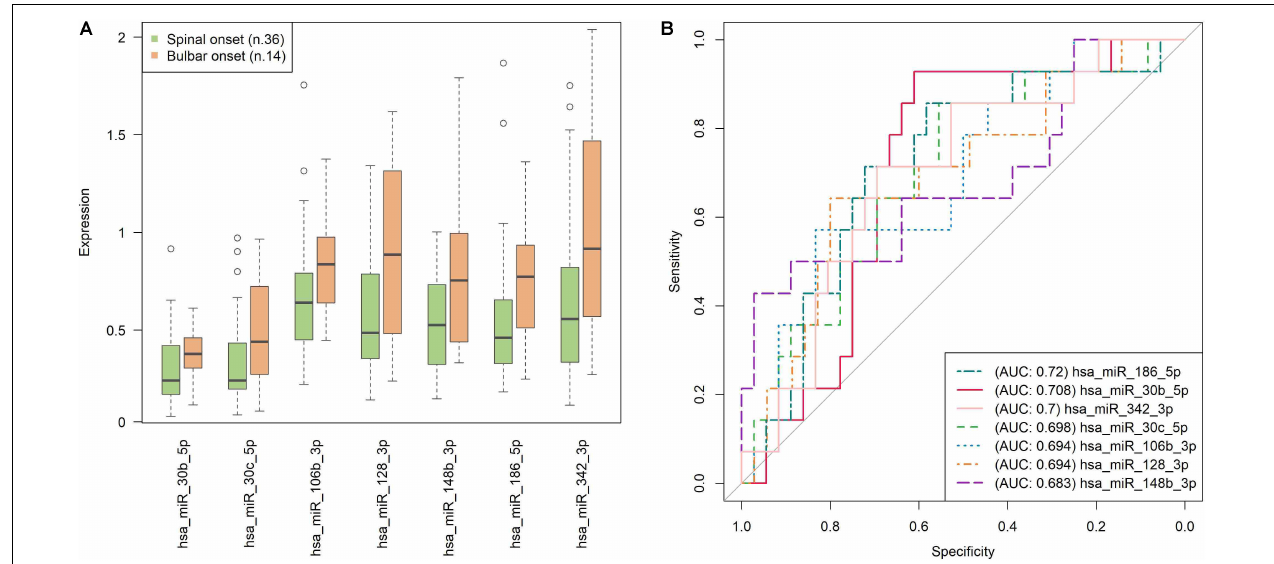
FIGURE 2 | Prediction accuracy of significant miRNAs with respect to the type of disease onset (spinal/bulbar). (A) Each boxplot shows the 25 th and the 75 th percentiles on the bottom and top of the box, the band inside the box is the 50 th percentile (the median) and the ends of the whiskers are the minimum and maximum of the data. Outliers are showed as isolated circles. (B) ROC curves based on miRNAs relative expression data (as resulted from qRT-PCR analysis). In our sample, the AUCs close to 0.7 suggest that none of the seven miRNAs exerts an exclusive impact on the type of sALS onset, but more likely they act together in order to modulate this phenotypic feature. Note that each value in the ROC curves is considered as a putative numerical threshold for separating the samples in the two onset conditions (spinal/bulbar). Then the sensitivity [true positive rate (TPR)] and Specificity [false positive rate (FPR)] are computed for that threshold. The more the expression values are not-overlapping between the two experimental conditions, the more the ROC curve is near the left and the top axes of the plot, and we obtain an area under the curve (AUC) = 1. The less the conditions are separable, the more the ROC curve approaches the bisector of the plot, with an AUC = 0.5.